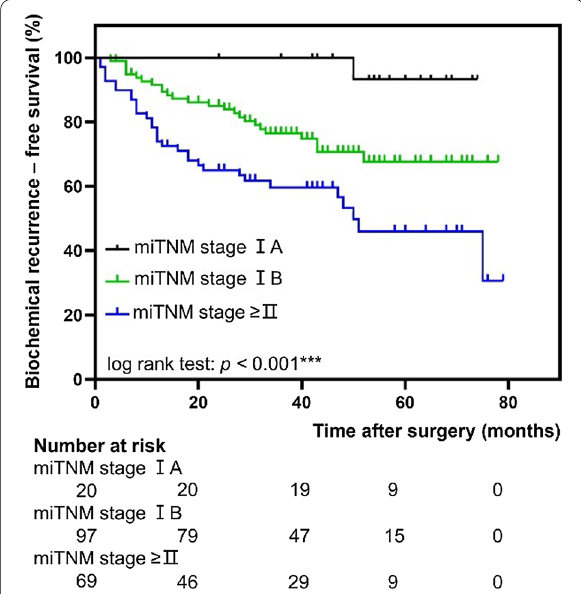
Fig. 1 Biochemical recurrence‑free survival according to miTNM stage. Pairwise comparison: miTNM stage IA versus miTNM stage IB, p 0.022; miTNM stage IA versus miTNM stage = stage IB versus miTNM stage